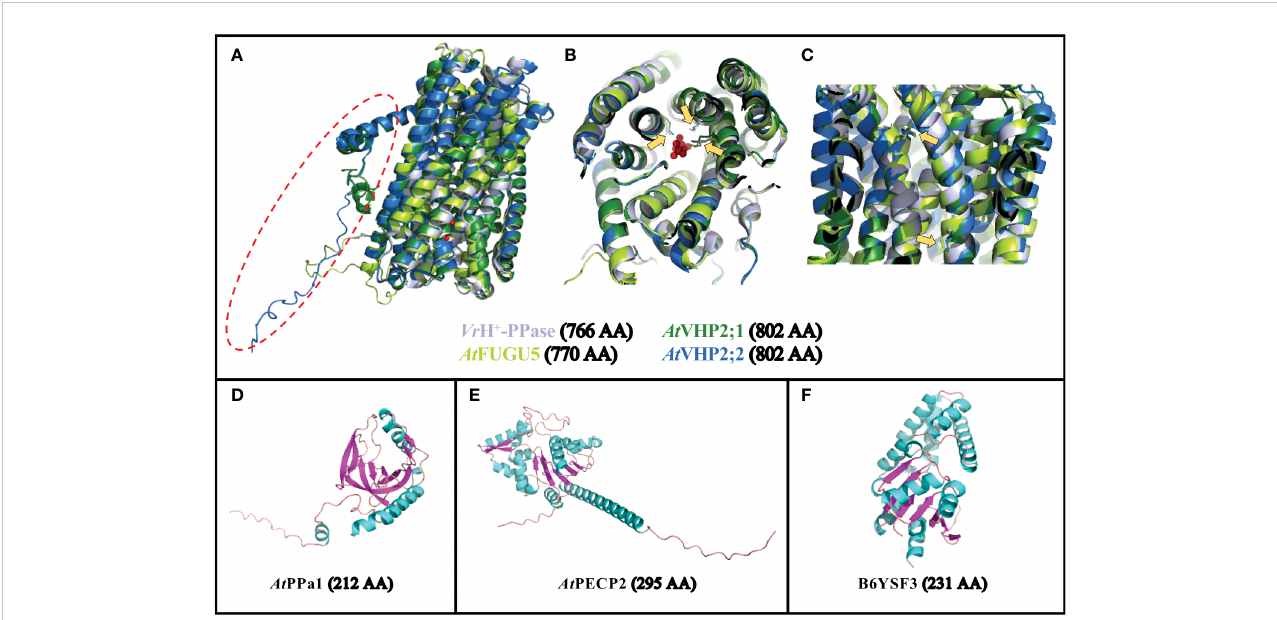
FIGURE 1 Predicted structures of selected PPases. (A – C) Overlay of the predicted structures for FUGU5 (UniProt P31414; in bright green),VHP2;1 (UniProt Q56ZN6; in dark green) and VHP2;2 (UniProt Q9FWR2; in blue) onto the crystal structure of Vr H + -PPase (PDB reference 4A01, Chain A; in light gray). (A) General overview of the 4 structures showing the strong conservation of these 16-TM proteins, with the exception of an additional N-terminal domain in VHP2;1 and 2;2 (surrounded by a red dotted circle). (B) Rotated view showing the positions of 3 AA (yellow arrows) involved in PPi binding in Vr H + -PPase, overlapping with the corresponding positions within the 3 predicted structures of FUGU5, VHP2;1 and VHP2;2. (C) Side view showing the positions of 2 AA (yellow arrows) involved in proton pumping in Vr H + -PPase, overlapping with the corresponding positions within the 3 predicted structures of FUGU5, VHP2;1 and VHP2;2. (D) Predicted structure for PPa1 (UniProt Q93V56). (E) Predicted structure for PECP2 (UniProt Q67YC0). (F) Predicted structure for T. onnurineus TON_0002 PPase (UniProt B6YSF3). The number of AA for the full-length proteins is indicated between brackets. AA, amino